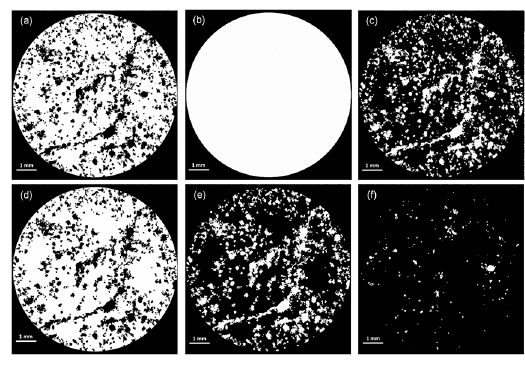
Figure 10. Pore discrimination for the 0.4X lens images: (a) Segmentation of the solid phase; (b) ROI tracing the object border, stretching over holes; (c) Total pores; (d) After eliminating individual black objects surrounded by white pixels in 3D (e) Open pores; (f) Closed pores.